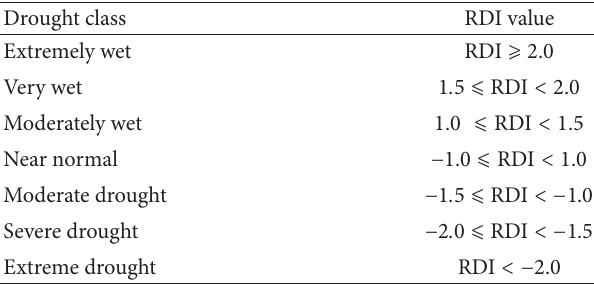
Table 2: Drought classification of